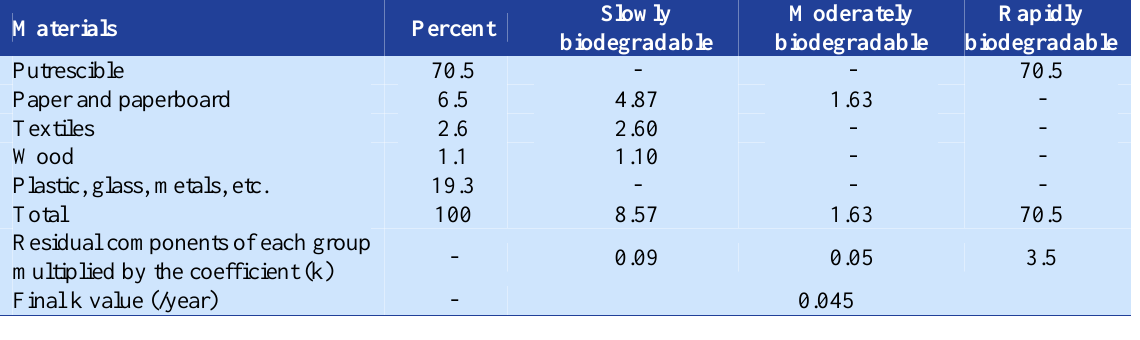
Table 2. Calculated k values (/year) based on the components of waste in 2012, and annual rainfall of 319 mm in Sanandaj